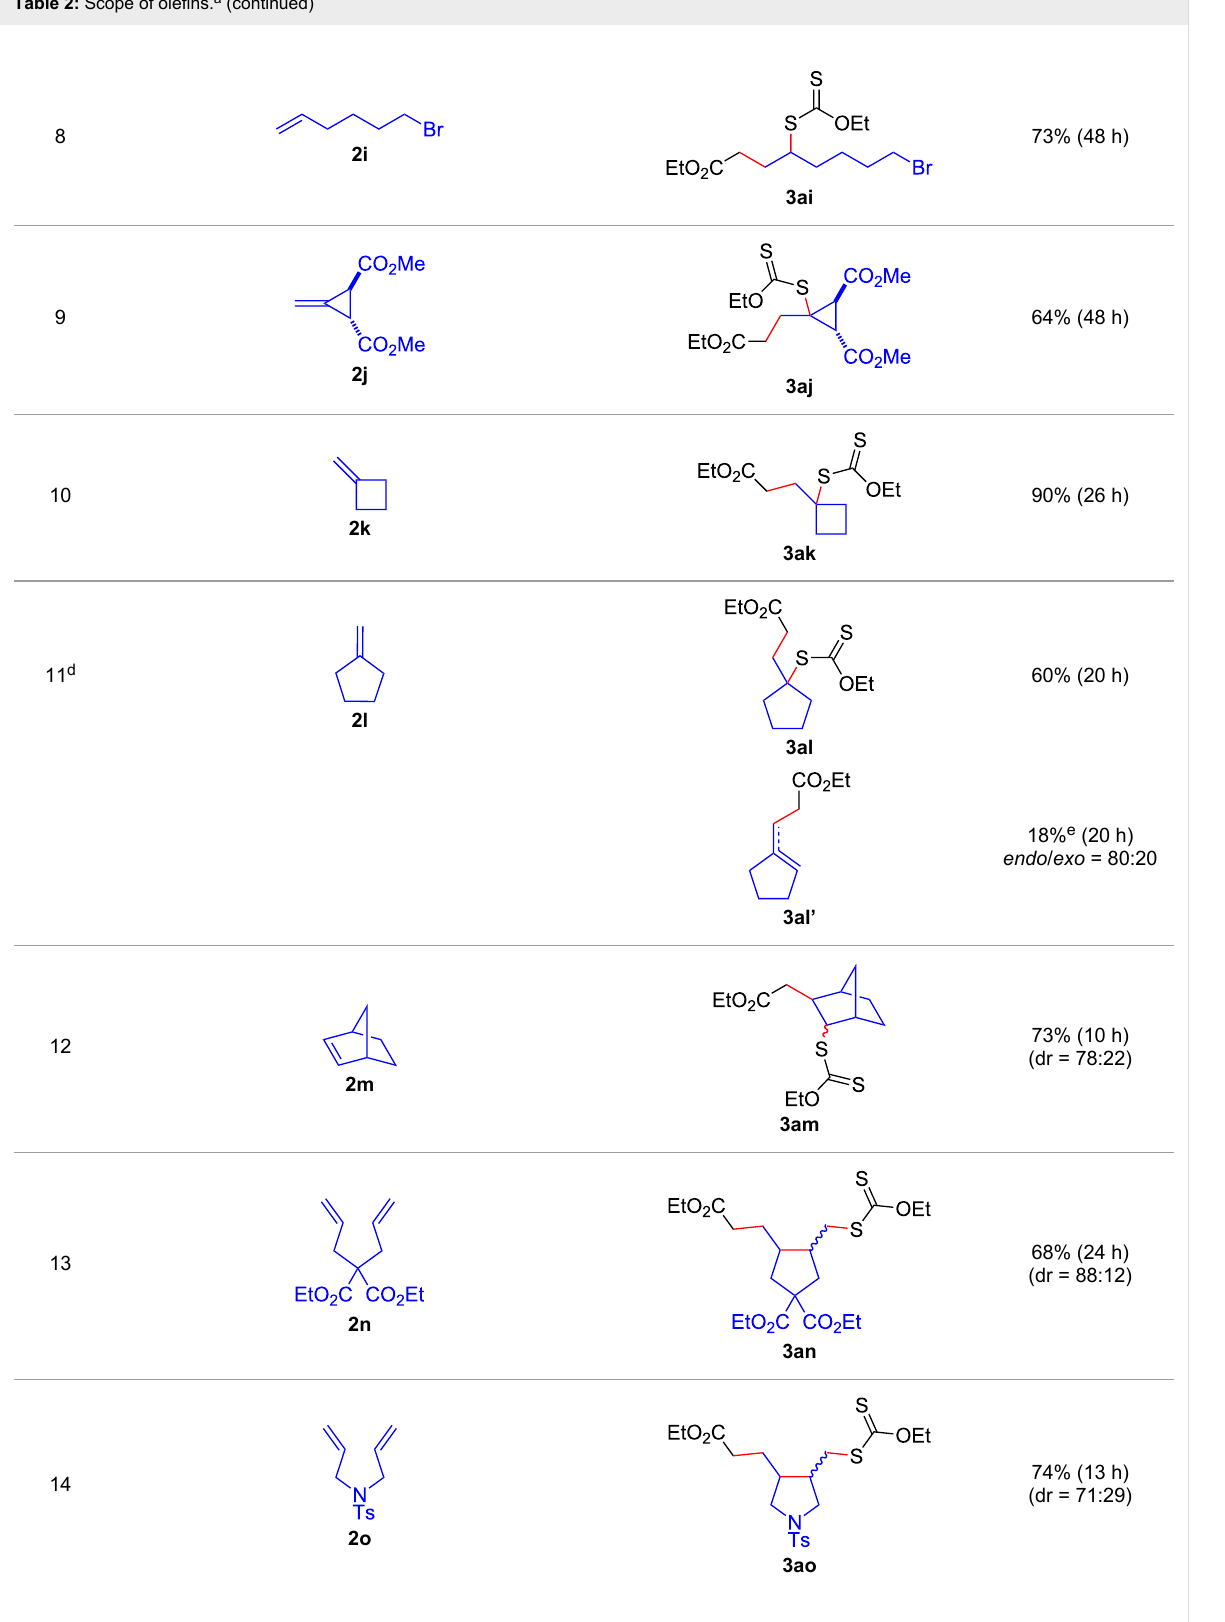
Table 2: Scope of olefins. a